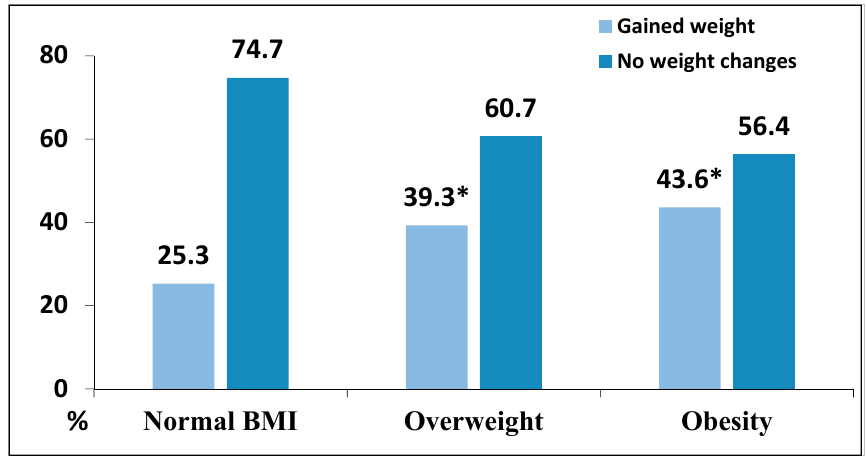
Figure 1. Association between body mass index (BMI) of the participants and weight gain during the quarantine (%). * p < 0.05 compared with normal BMI (z test with Bonferroni correction).